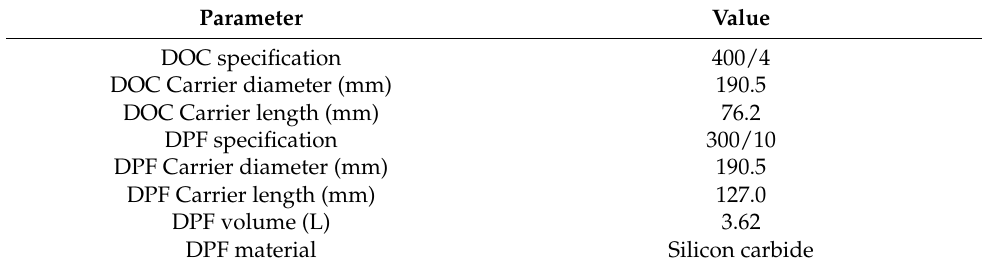
Table 5. Basic parameters of DOC and